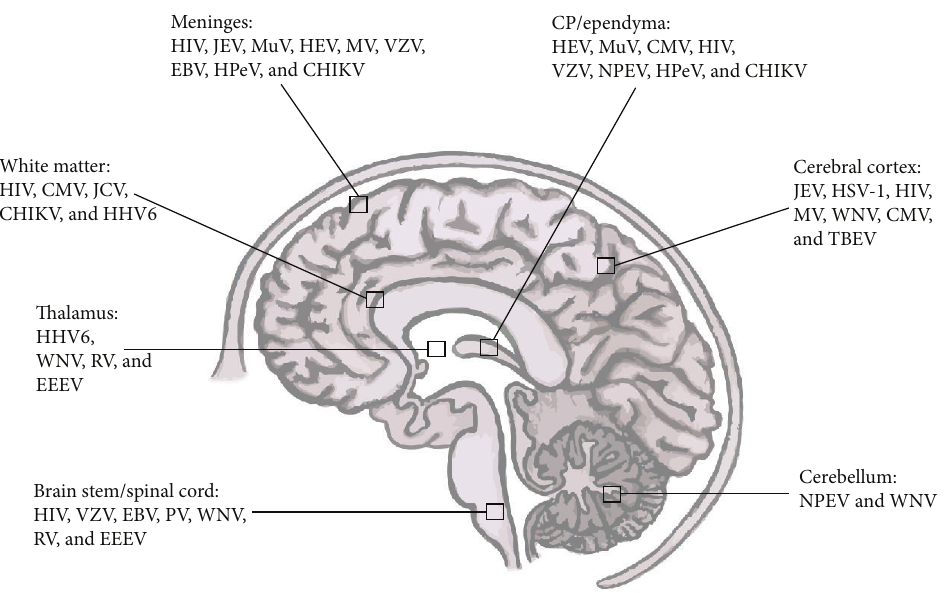
Figure 3: Relevant encephalitis and meningitis causing viruses in humans allocated to the brain region they may affect. CHIKV, chikungunya virus; CMV, cytomegalovirus; EBV, Epstein Barr virus; EEEV, eastern equine encephalitis virus; HHV-6, human herpes virus-6; HIV, human immunodeficiencyvirus;HPeV,humanparechovirus;HSV-1,herpessimplexvirus-1;JCV,JohnCunninghamvirus;JEV,Japaneseencephalitis virus; MV, measles virus; MuV, mumps virus; NPEV, nonpolio enterovirus; PV, poliovirus; RV, rabies virus; TBEV, tick-borne encephalitis virus; WNV, West Nile virus; VZV, varicella zoster